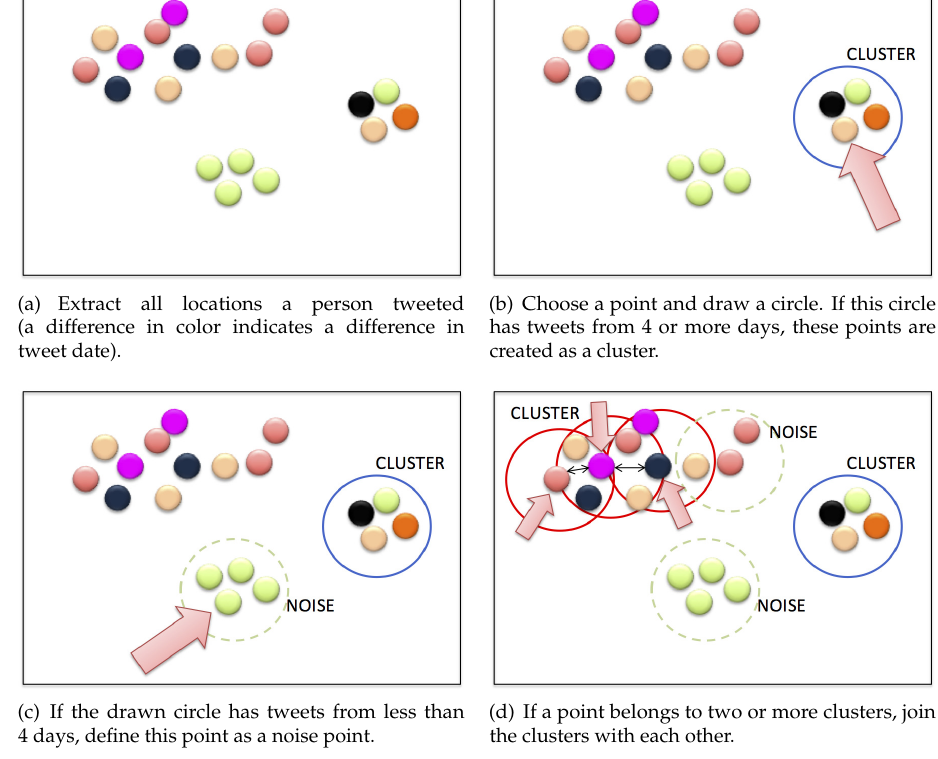
Figure 1. Modified DBSCAN (Density-Based Spatial Clustering Algorithm with Noise) for geotagged tweet